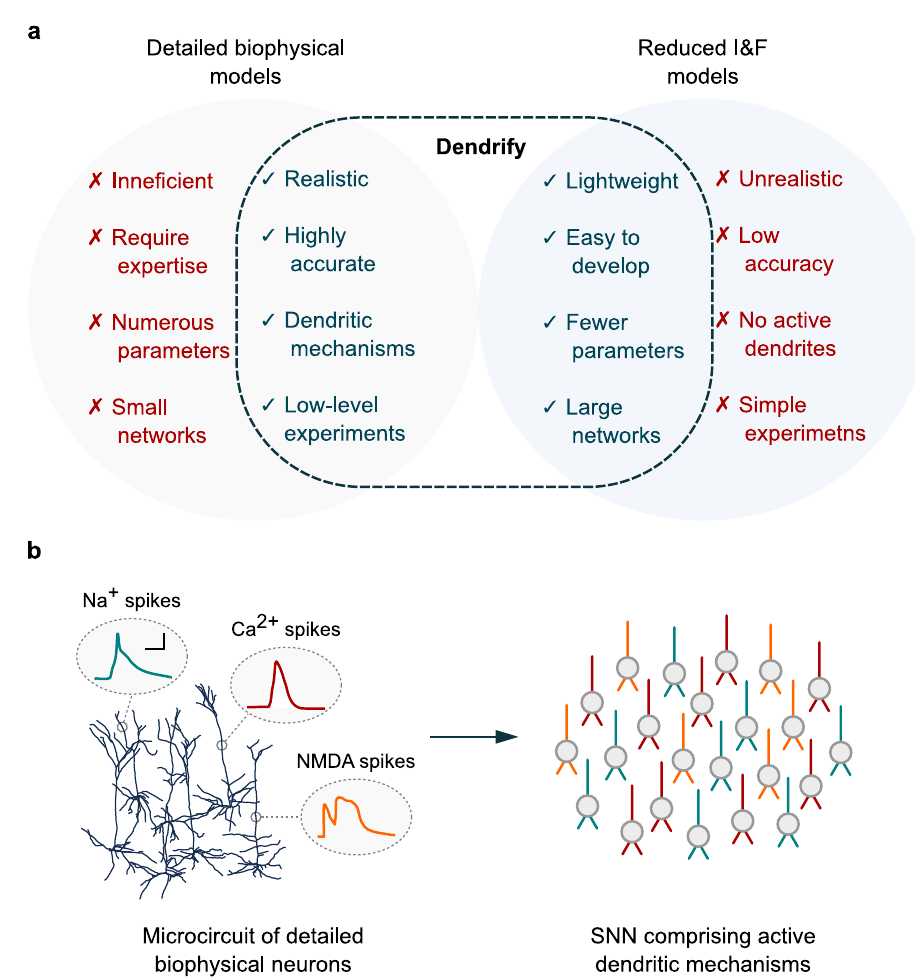
Fig.1|Themaincharacteristicsofdendrify.a Dendrifystemmedfromourefforts to bridge the gap between detailed biophysical models and reduced I&F